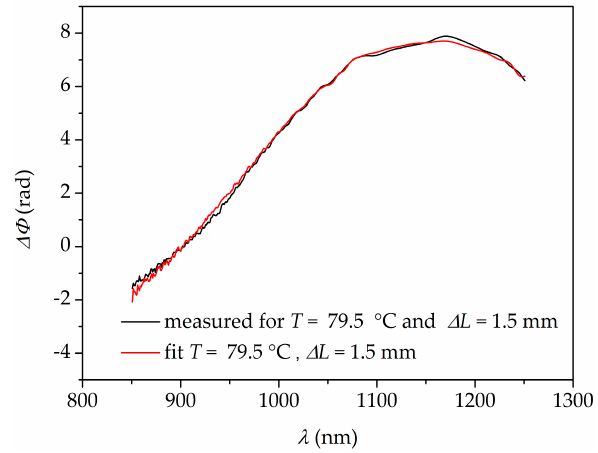
Figure 12. Measured differential phase shift response of the interferometer to simultaneously applied elongation and temperature, and the best fit thereof.